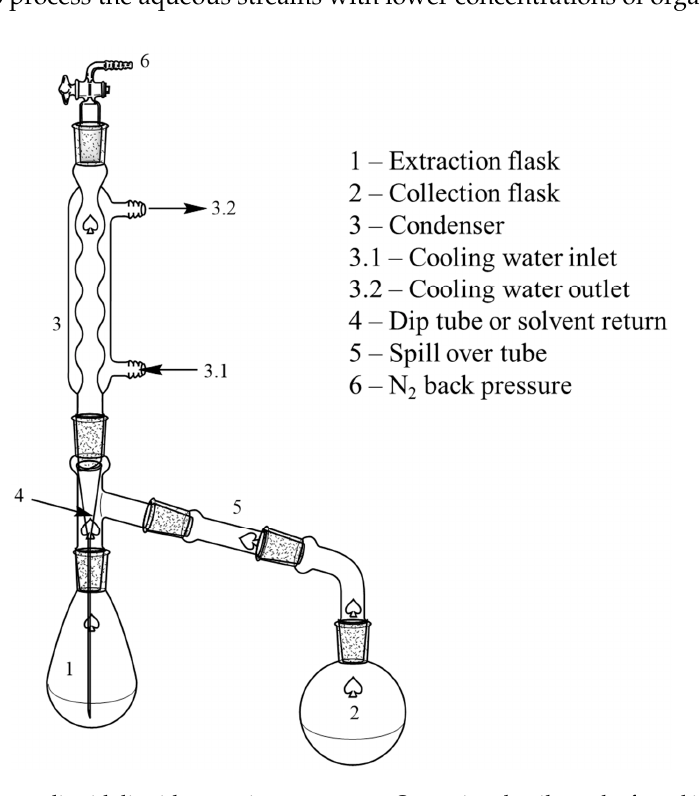
Figure 1. Continuous liquid–liquid extraction apparatus. Operation details can be found in Appendix